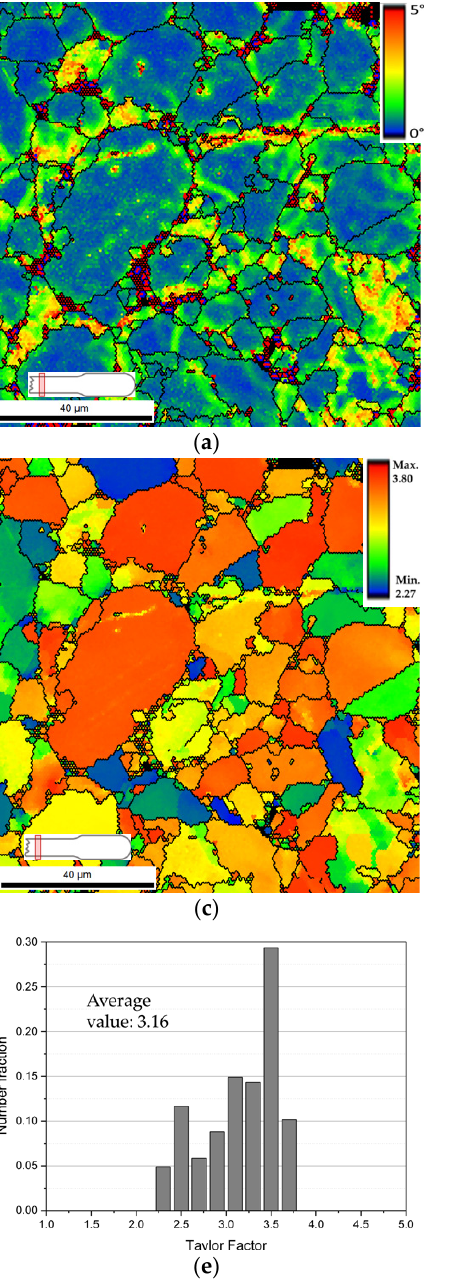
Figure 12. ( a , b ) 2nd neighbor kernel average misorientation (KAM) maps, ( c , d ) tensile Taylor factor maps and ( e , f ) Taylor factor distribution of ( a , c , e ) Al and ( b , d , f ) Al/CNT tensile test specimen 2.0 mm from the fracture surface.